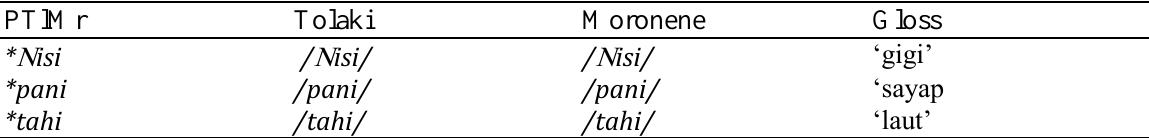
Table 6. The Final Word Position PTlMr